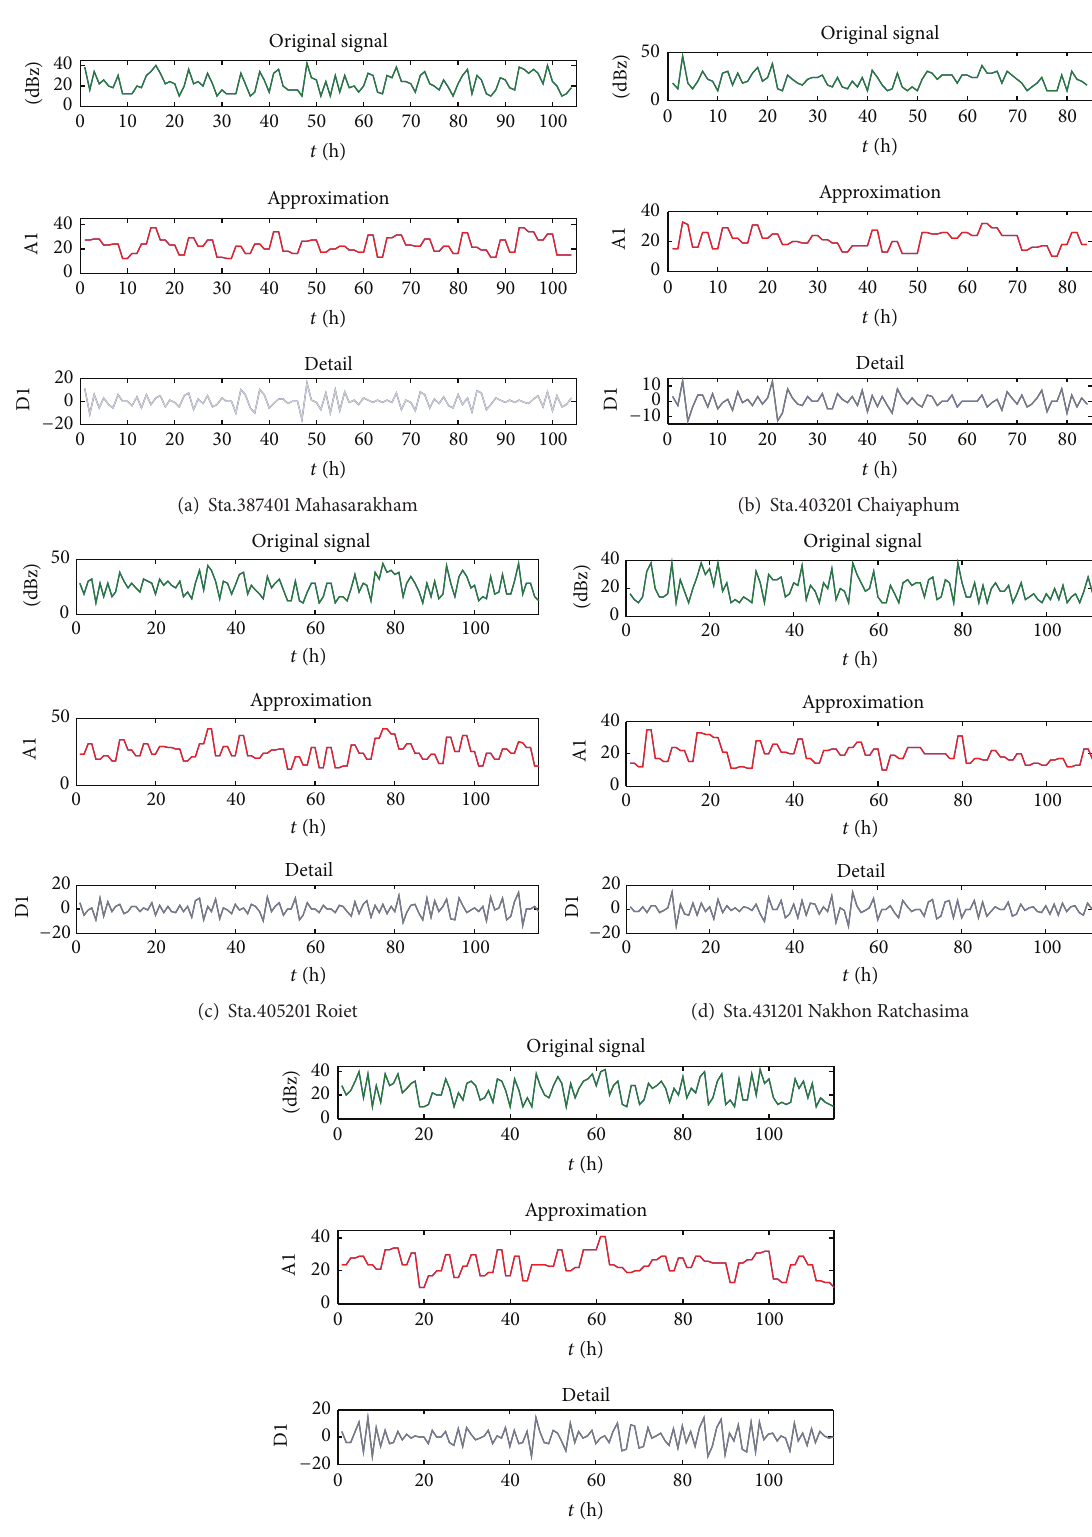
Figure 6: Radar reflectivity data filtration by Haar wavelet filter type for each